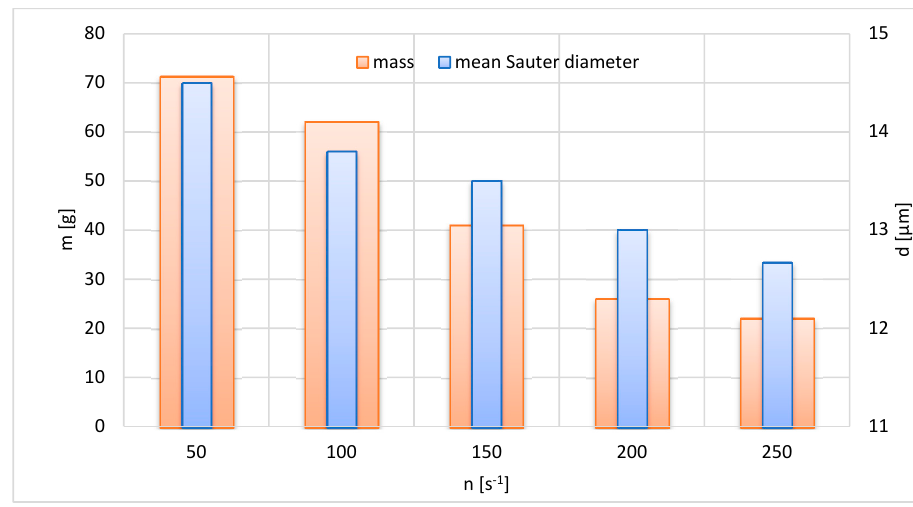
Figure 9. Effect of the rotational speed of the classifier rotor on mass and mean Sauter diameter of the grinding product; p = 400 kPa, t = 1200 s.